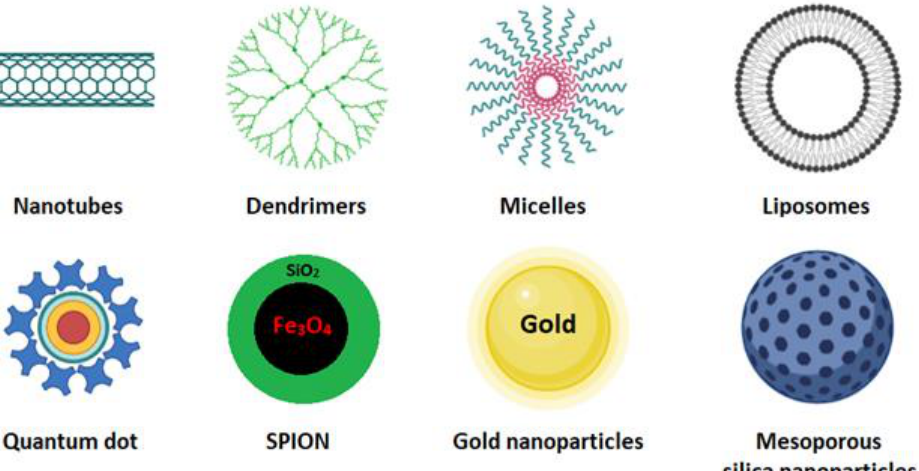
Figure 1. Schematic representation of some nanocarriers currently used as smart drug-delivery systems [10].